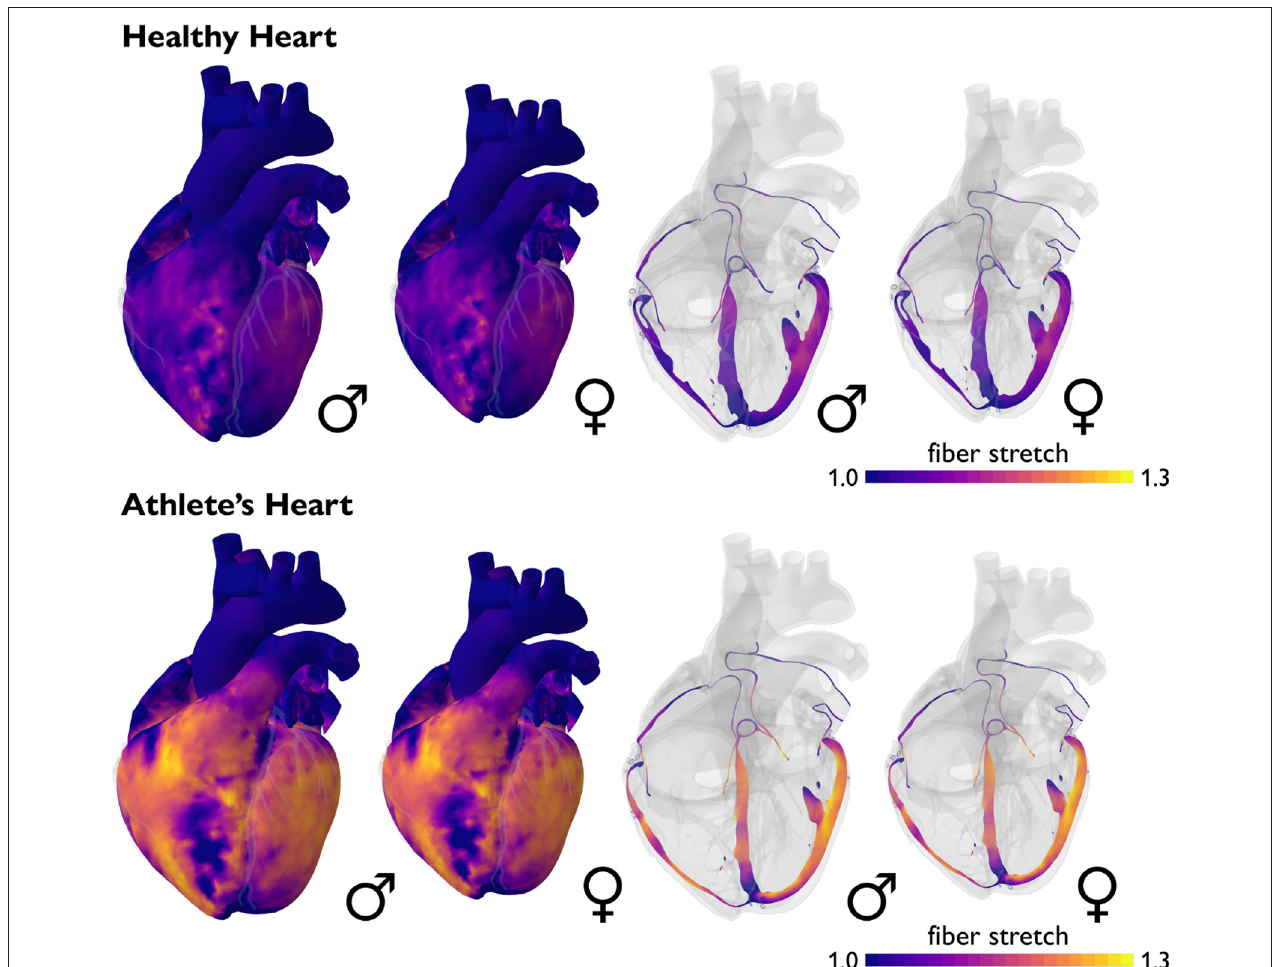
FIGURE 6 | Sex differences in short-term fiber stretch and elastic response. Simulated short-term fiber stretch for male and female hearts, left and right, subject to the stroke volumes of healthy and athlete’s hearts, top and bottom. In the healthy heart, simulated fiber stretches remain well within the physiological regime of 1.10 to 1.15, with a few local peaks on the order of 1.20. In the athlete’s heart, simulated fiber stretches would exceed the physiological regime and reach values of 1.20 to 1.30, with almost the entire heart experiencing stretches above 1.20. Volume overload on the whole heart level induces an overstretch on the cellular level and triggers physiological adaptation in the athlete’s heart. Male and female hearts respond similarly under both healthy and athletic conditions.